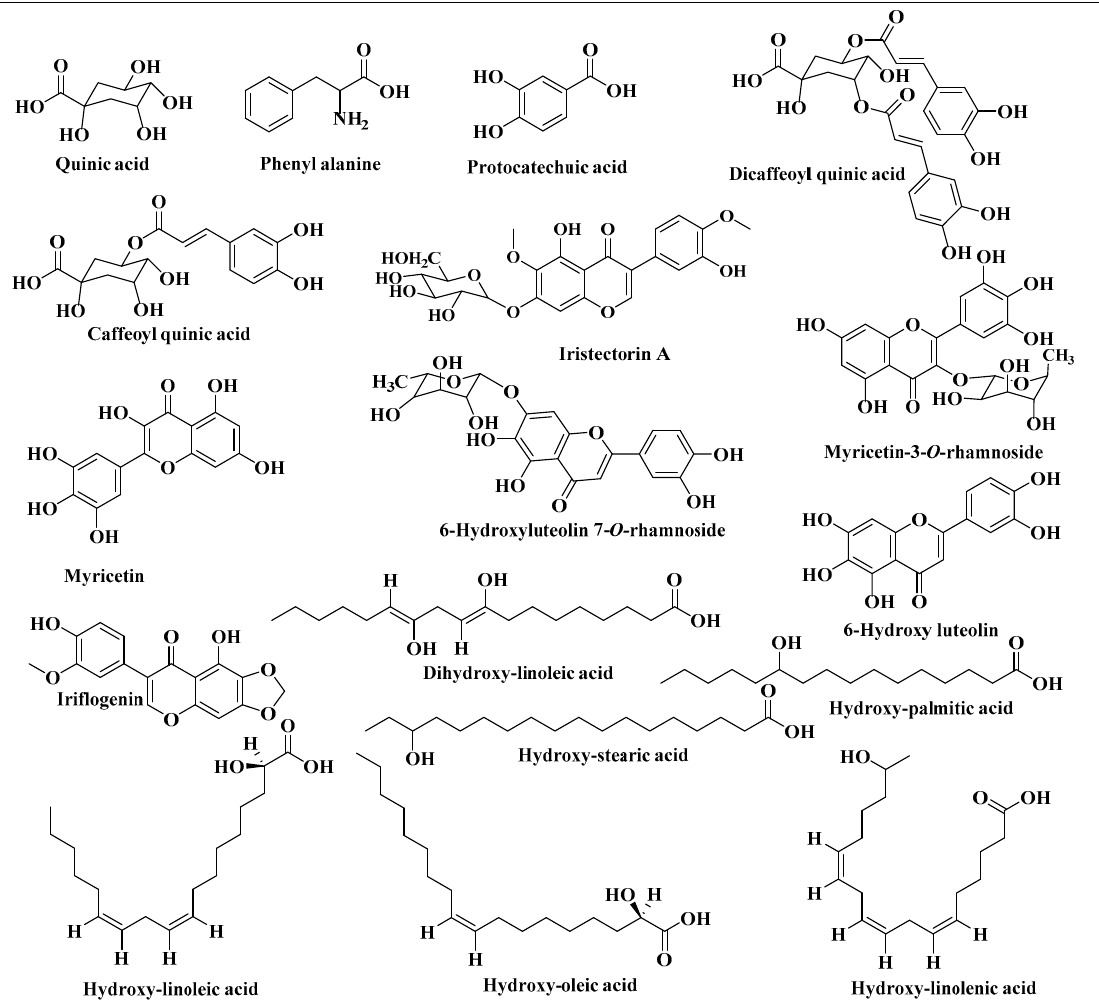
Figure 3. Major compounds identified in C. aethiopica leaf total methanol extract using HPLC-ESI-MS in the negative ion mode. Table 3. Anti-allergic effects of C. aethiopica leaf total methanol extract and its fractions at different concentrations using degranulation assay in RBL-2H3 cell line.